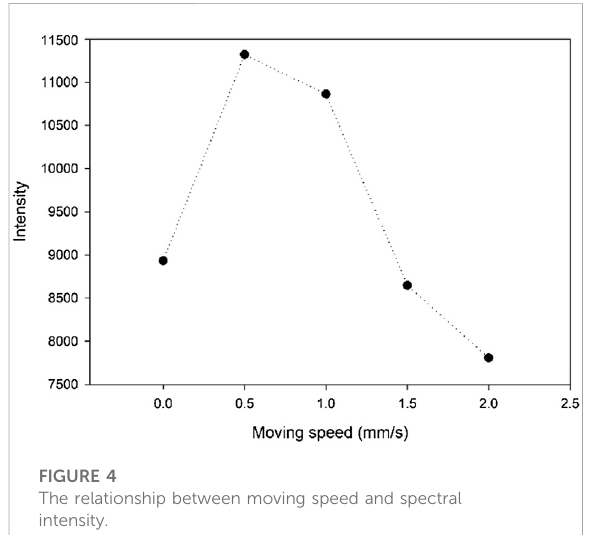
FIGURE 4 The relationship between moving speed and spectral intensity.